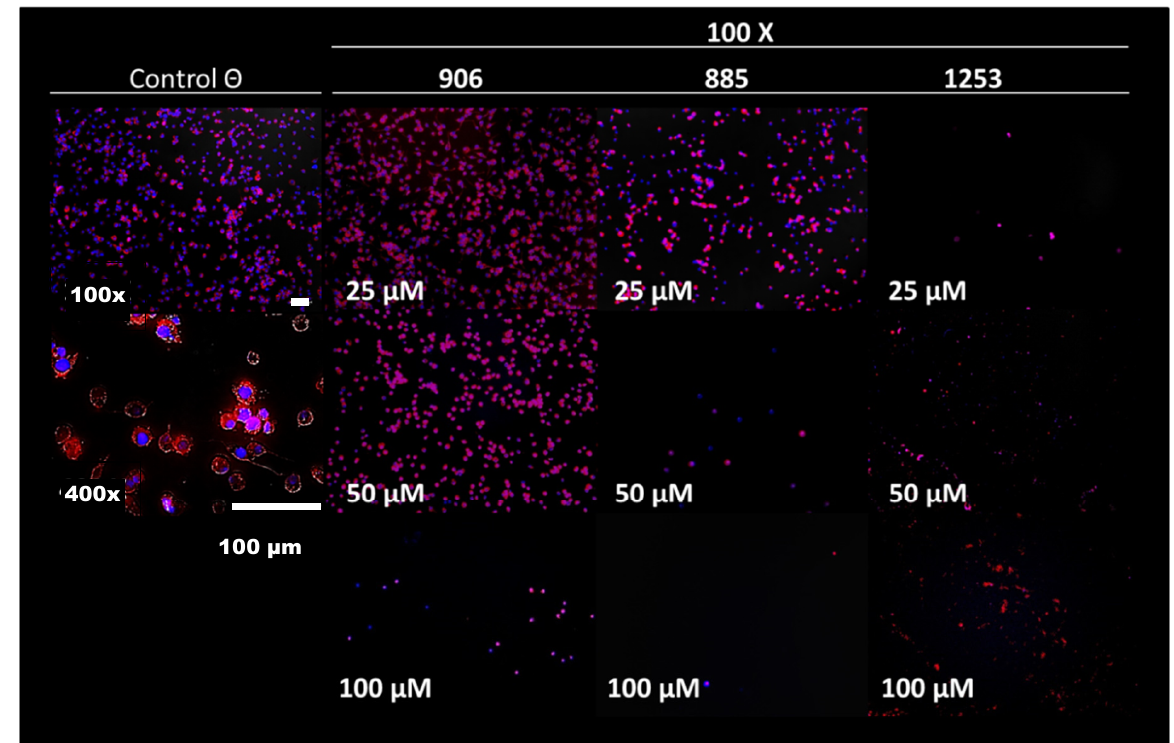
Figure 1. Dose–response profile of compounds 906, 885, and 1253 . Confocal fluorescent microscopy of BME26 cells incubated for 24 h with different concentrations of the compounds (25, 50, and 100 µM, at 100× magnifications). Following incubation, cells were stained with DAPI and phalloidin to observe the cell architecture (at 100× and 400× magnifications, the white bars on the bottom, indicates the 100 µm scale size).